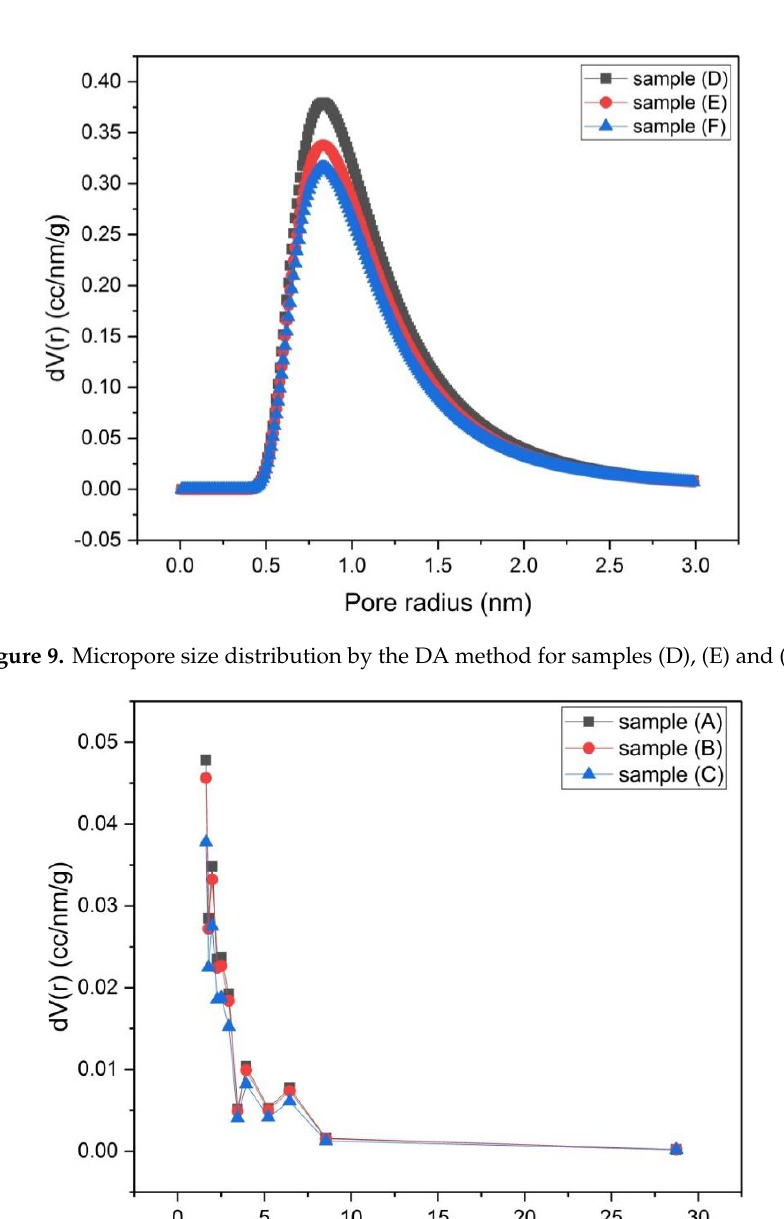
Figure 9. Micropore size distribution by the DA method for samples (D), (E) and (F).